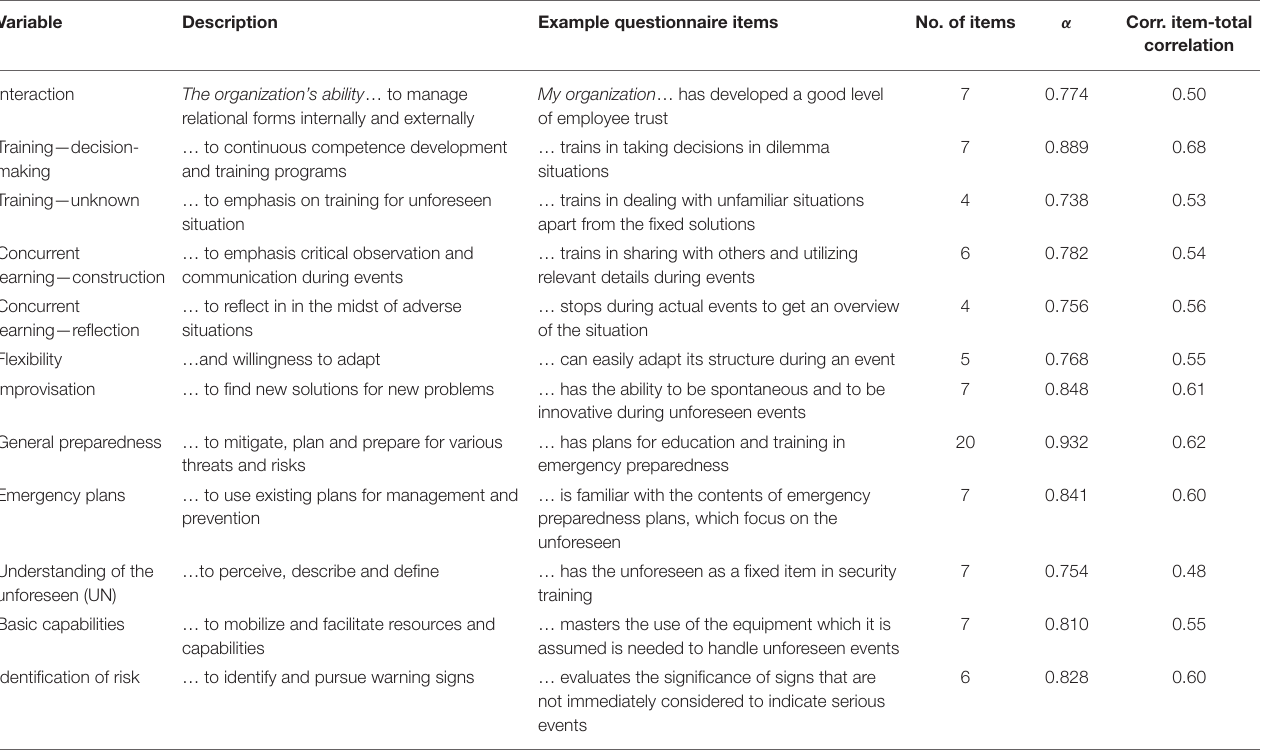
TABLE 1 | Descriptions, example items, number of items, Cronbach’s alpha, and corrected item-total correlation for the Unforeseen organization (UN-ORG)